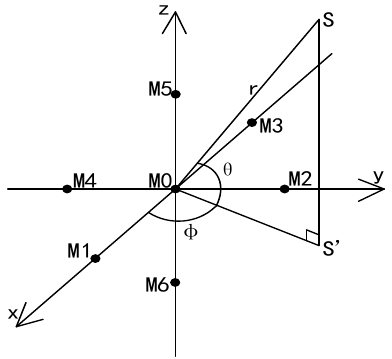
Figure 1. Three-plane five-element microphone array.